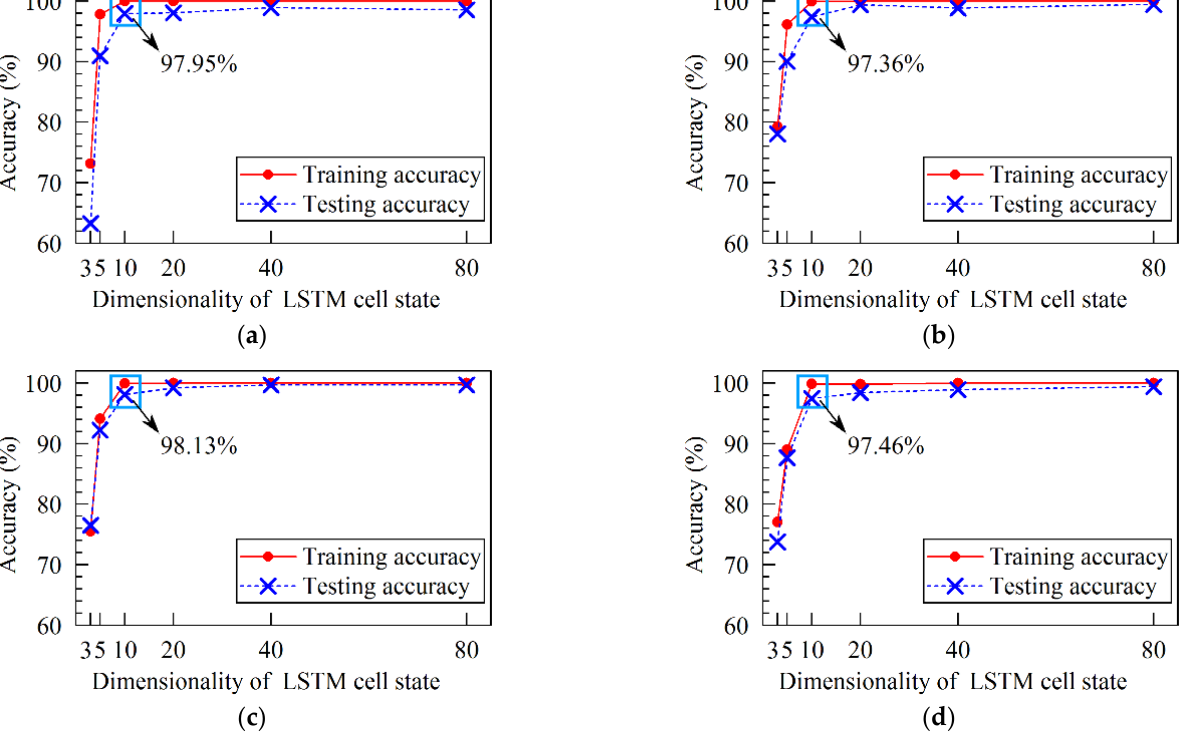
Figure 13. Training and testing accuracies of the second network structure. ( a ) Mode 2_a. ( b ) Mode 2_b. ( c ) Mode 2_c. ( d ) Mode 2_d. The cyan boxes mark the accuracies that are more than 95% with the lowest number of hidden layer elements.